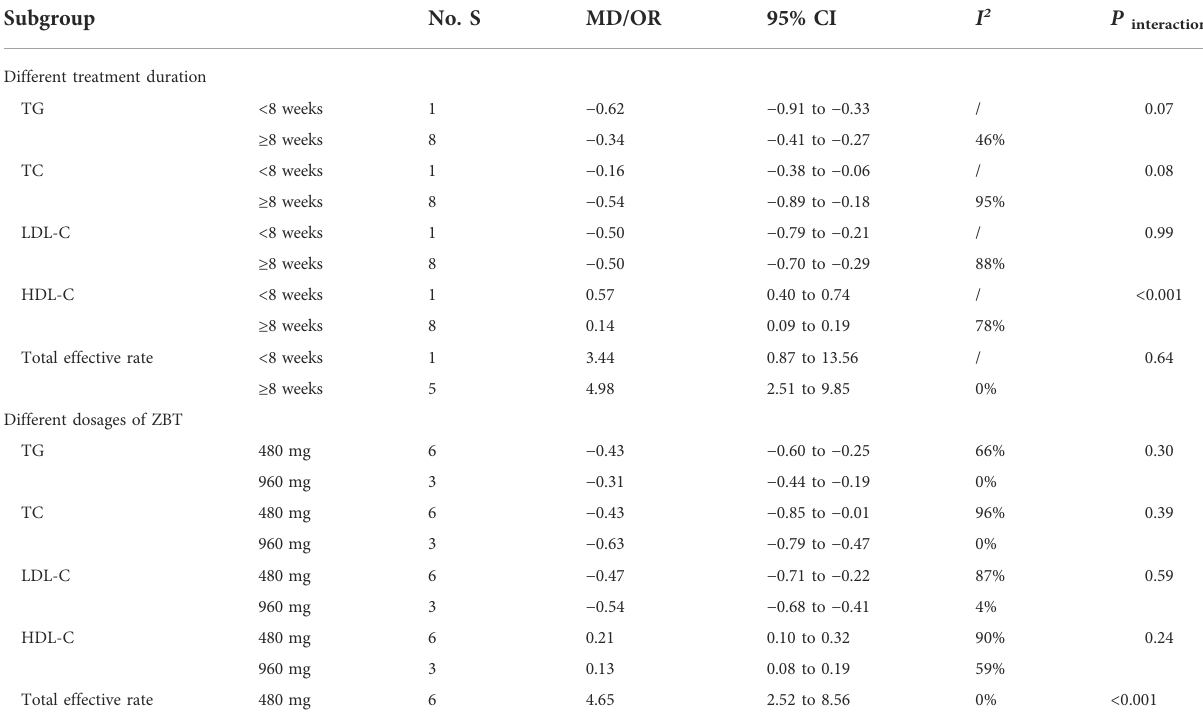
TABLE 5 Subgroup analysis of the main ef fi cacy outcomes of ZBT + CT vs.